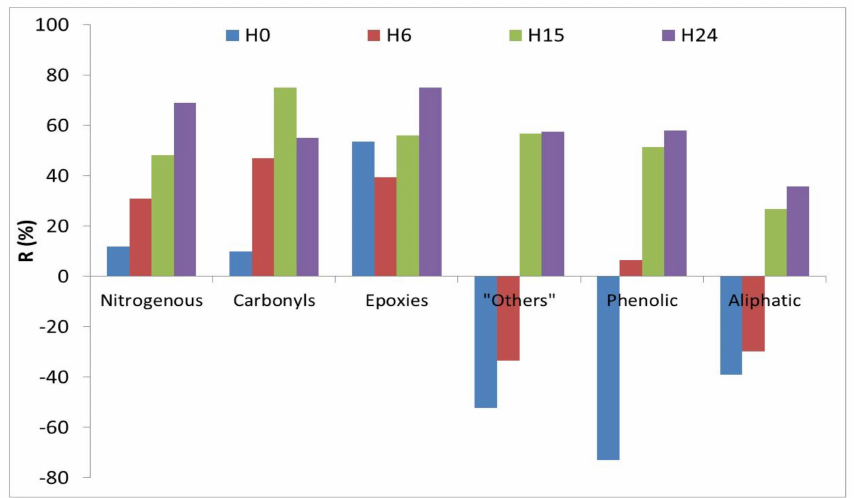
Figure 7. Reductions of the groups of compounds considered in the condensed fraction vs. hy- drothermal treatment